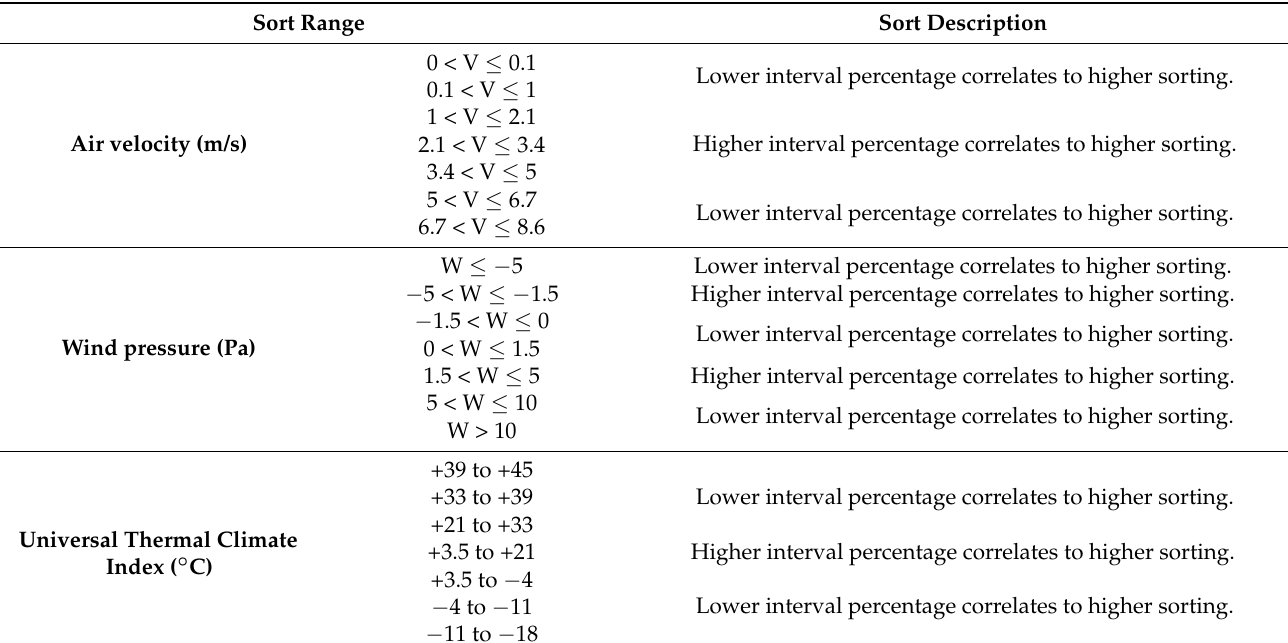
Table 7. Sort range and sort description of wind environment and UTCI